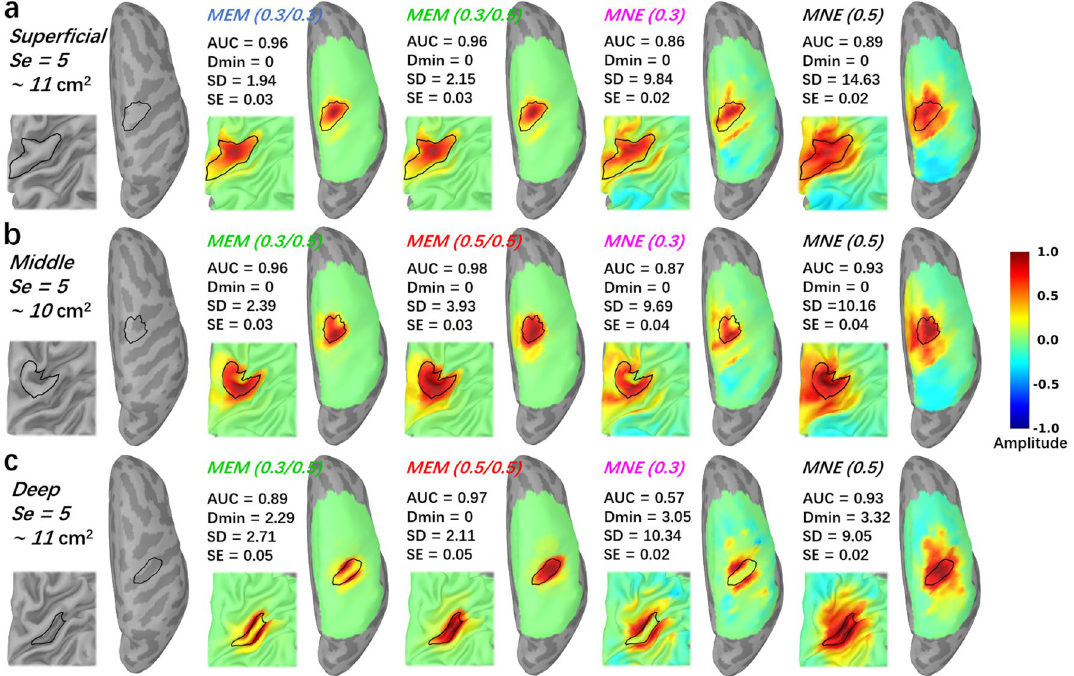
Figure 4. Comparisons of the reconstruction maps using MEM and MNE in realistic simulations. Three theoretical regions with spatial extent Se = 5 ( 11c m 2 ) were selected near the ‘hand knob’ at different depth. The first column presents the locations and the size of the generator along the cortical surface. ( a ) Superficial seed case with reconstructed maps reconstructed using all MEM and MNE implementations considered in this study. ( b ) Middle seed case with reconstructed maps reconstructed using all MEM and MNE implementations considered in this study. ( c ) Deep seed case with reconstructed maps reconstructed using all MEM and MNE implementations considered in this study. 20% inflated and zoomed maps are presented on the left corner of each figure. 100% inflated right hemisphere are presented on the right side. All the maps were normalized by their own global maximum and no threshold was applied. Figure created by Brainstorm 59 using the NIRSTORM plugin developed by our team (https:// github. com/ Nirst